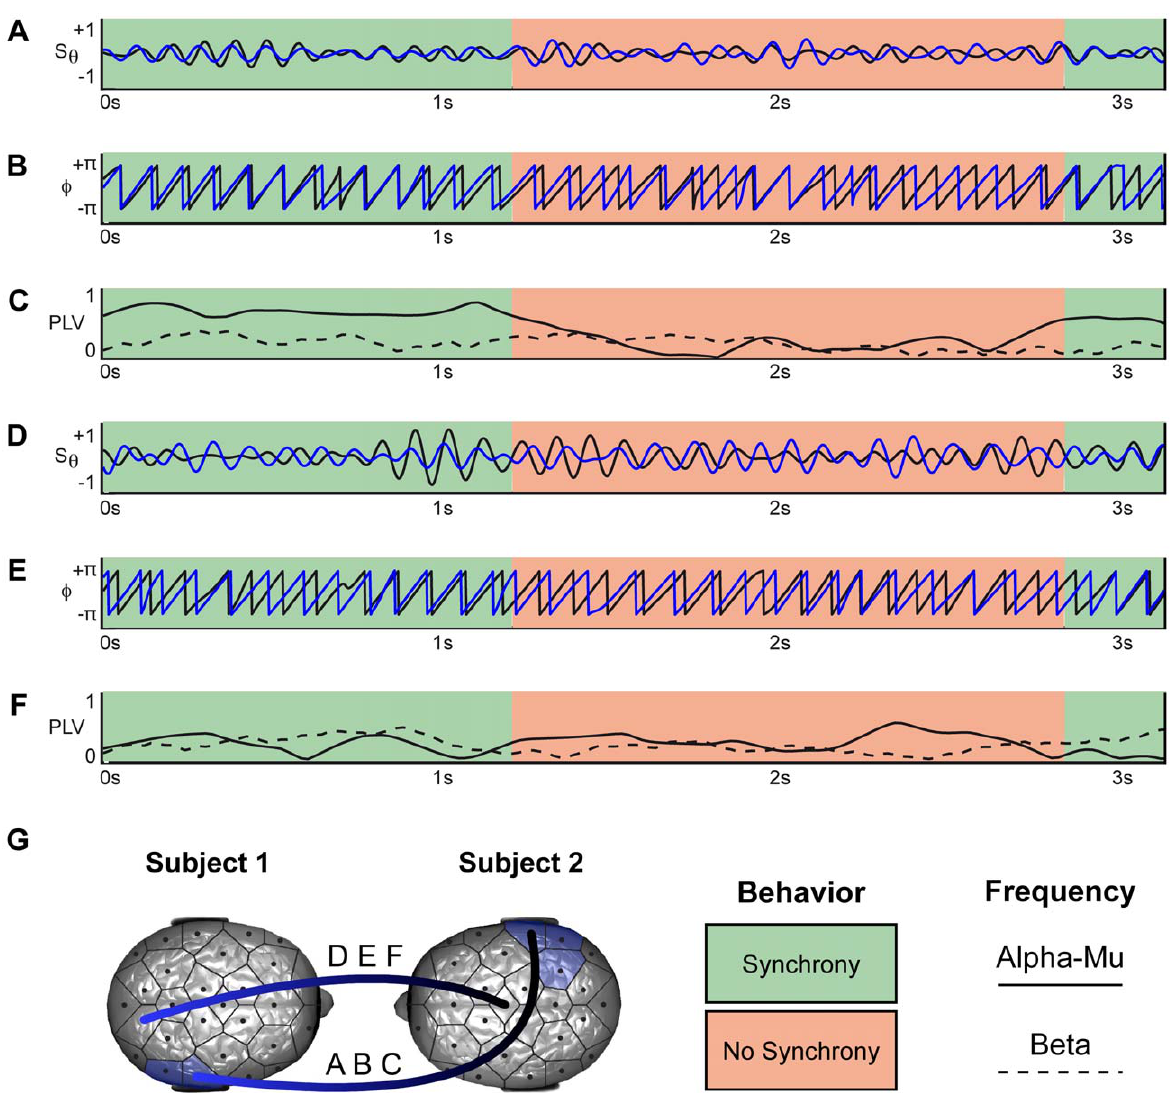
Figure 3. Brain synchronization: online example. Samples of spontaneous imitation episodes in the dyad n u 3 showing the correspondence between interactional synchrony and brain activities. The green areas indicate periods where subjects were behaviorally synchronized and the red ones periods without behavioral synchrony. A. Time course of normalized EEG signal filtered in the alpha-mu frequency band for the channels P8 of both subjects. These channels are members of the cluster shown in figure 2A. B. Phase extracted from the signals. C. PLV calculated with sliding centred time windows of 800ms length in the alpha-mu band (related to A and B) quantifying the neural synchronization between the two subjects. Beta band PLV for the same electrodes is also shown in dashed line. D. Time course of normalized EEG signal filtered in alpha-mu frequency band for the channels PO2 in Subject 1 and Cz in Subject 2. Those channels are not members of any clusters. E. Phase extracted from the signals. F. PLV calculated with sliding centred time windows of 800ms length in the alpha-mu band (related to D and E) quantifying the neural synchronization between the two subjects. Beta band PLV for the same electrodes is also shown in dashed line. G Representation of the pairs of electrodes P8-P8 (A,B,C) and PO2-Cz